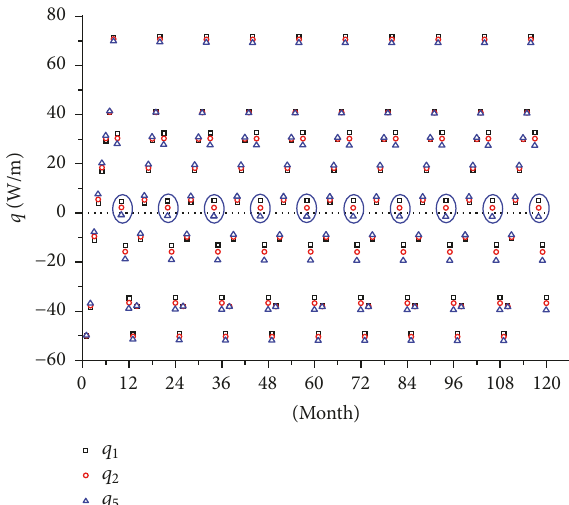
Figure 6: Monthly average heat fluxes for different boreholes (spacing =